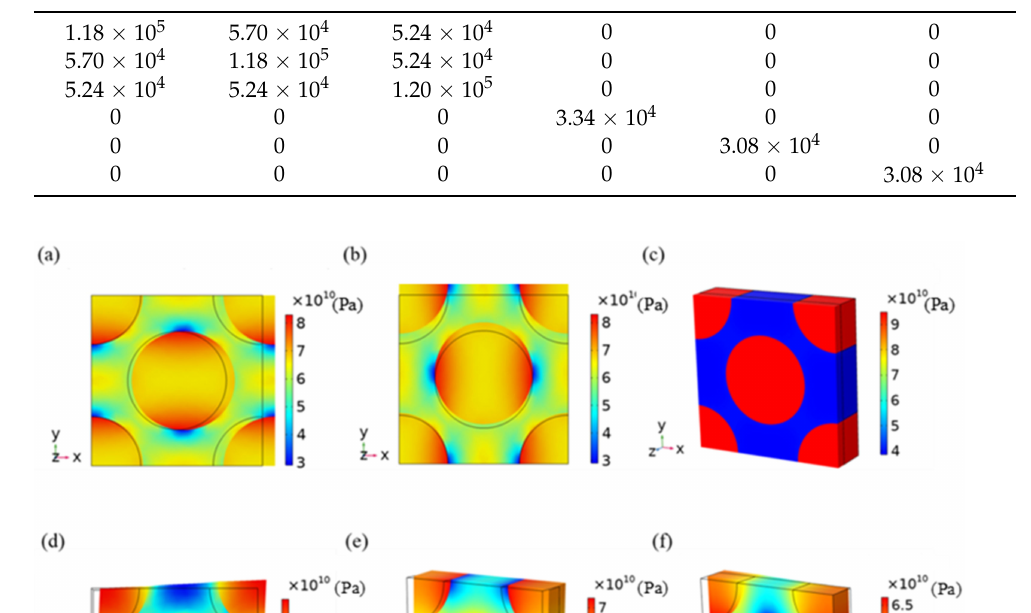
Table 2. When T = 4 K and ε = 0.003, the stiffness matrix, C 1 (MPa), of the EAS-Nb 3 Sn level 1 homogeneous fiber bundle considering fiber damage is shown.